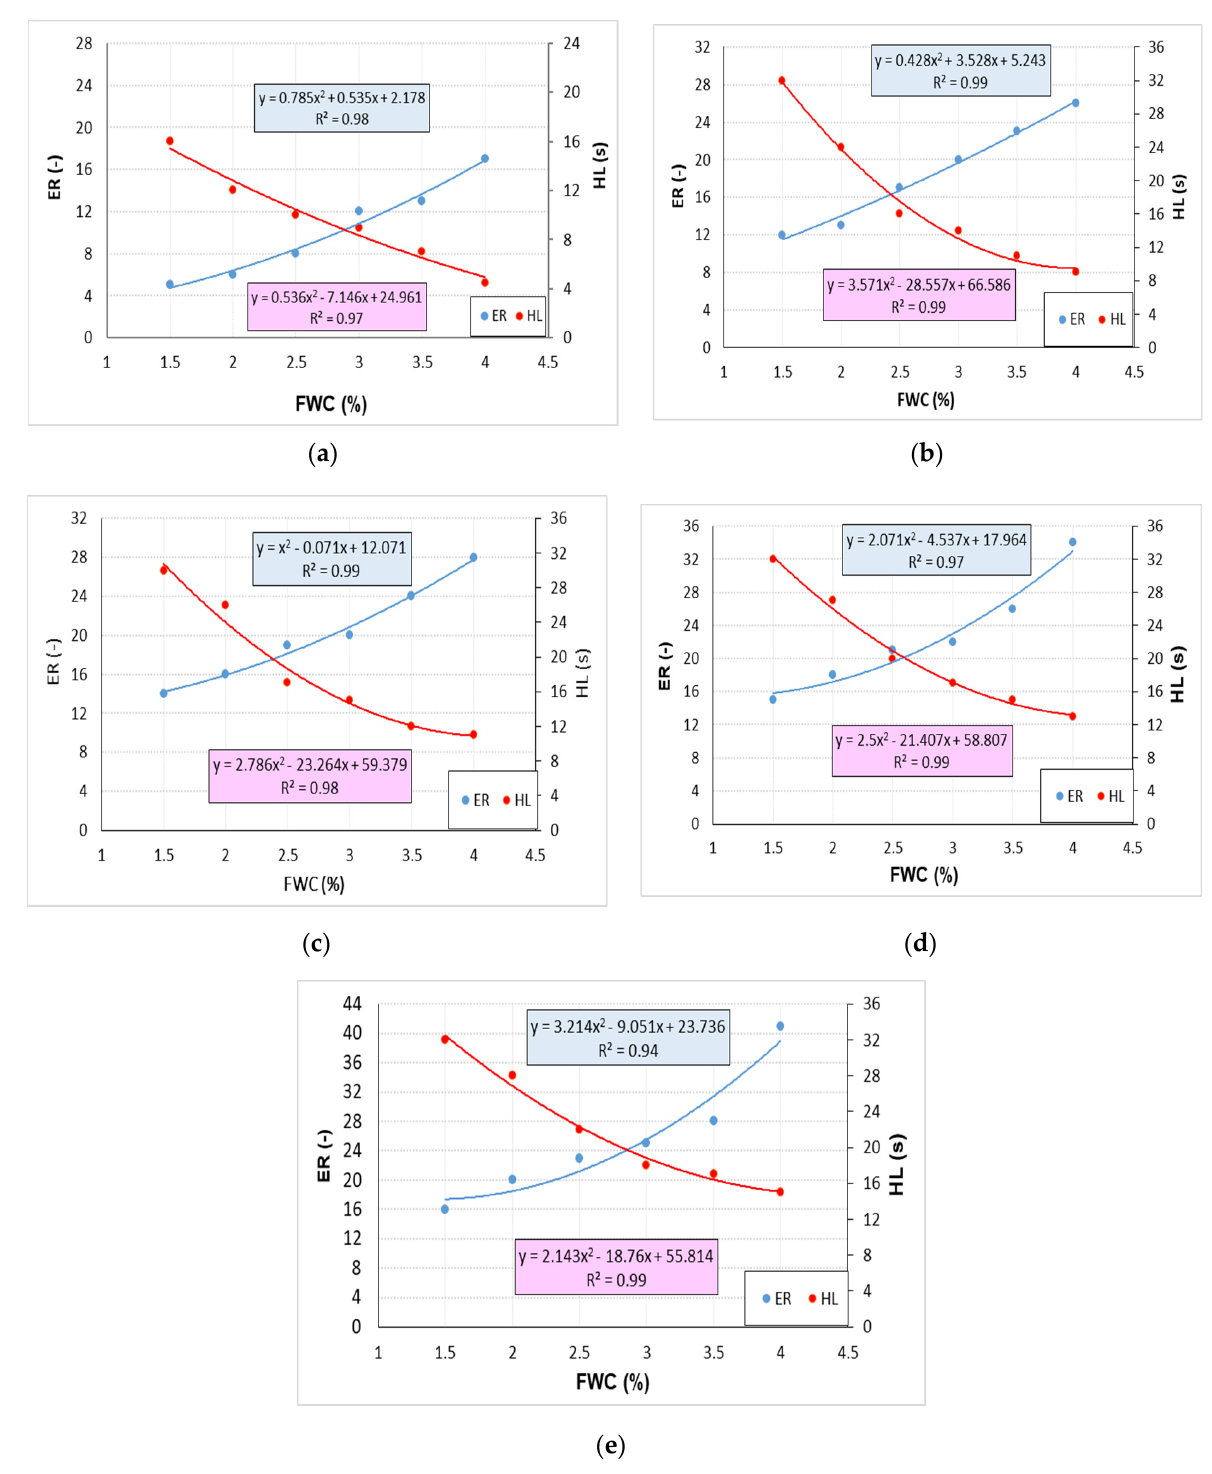
Figure 20. Bitumen 50/70 foam characteristics ( a ), bitumen 50/70 + 0.6% SAA + 1.5% F–T ( b ), bitumen 50/70 + 0.6% SAA+ 2.0% F–T ( c ), bitumen 50/70 + 0.6% SAA + 2.5% F–T ( d ), bitumen 50/70 + 0.6% SAA + 3.0% F–T ( e ).